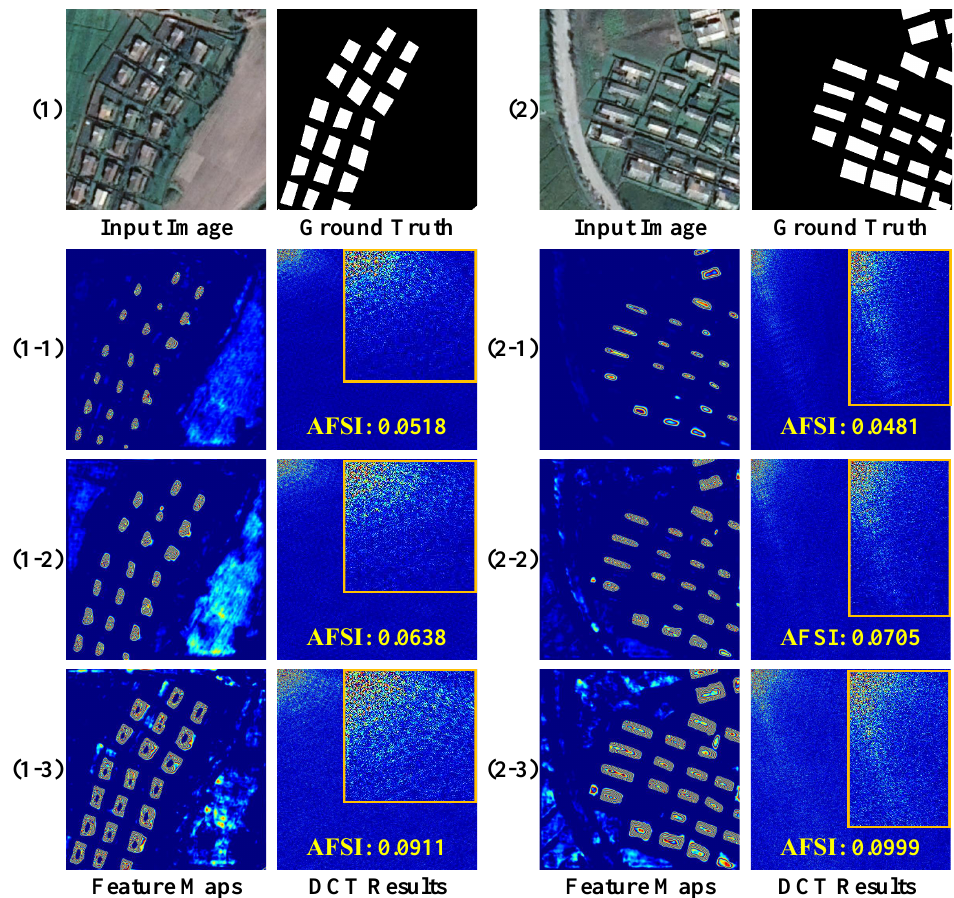
Figure 7. The feature maps and DCT results on the East Asia Dataset. Image ( 1 ): (( 1-1 )–( 1-3 )) represent different feature maps and their corresponding DCT results, respectively; image ( 2 ): (( 2-1 )–( 2-3 )) denote different feature maps and their corresponding DCT results,